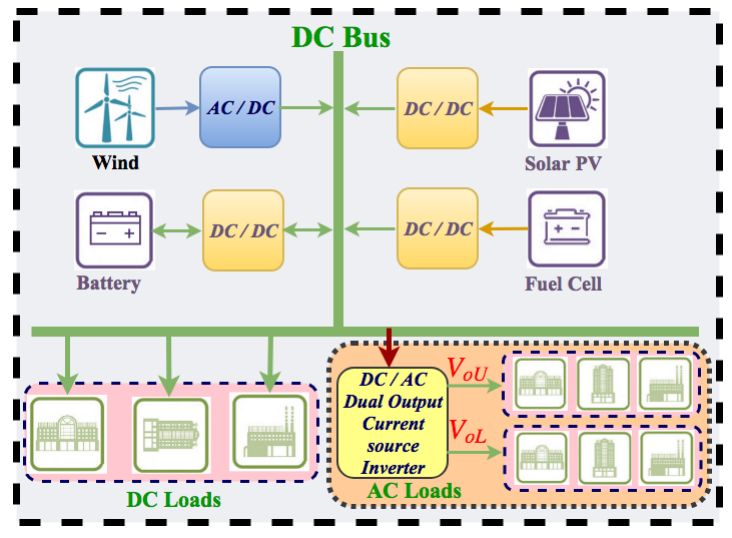
Figure 3. Schematic of